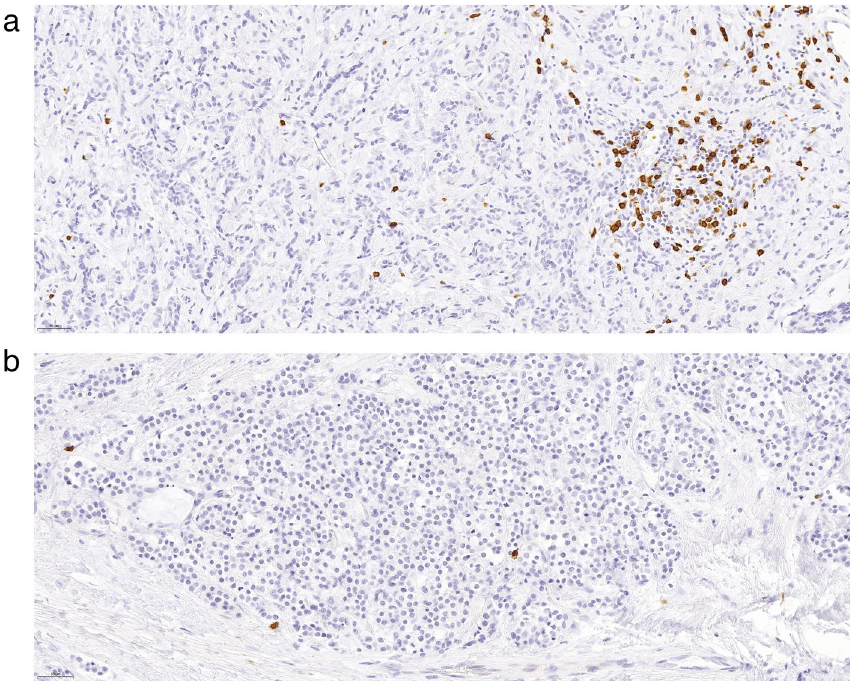
Fig. 4 CD8-staining of a PT and the corresponding R ( a ) PT,CD8 percentage 10% ( b ) R, CD8 percentage 3%